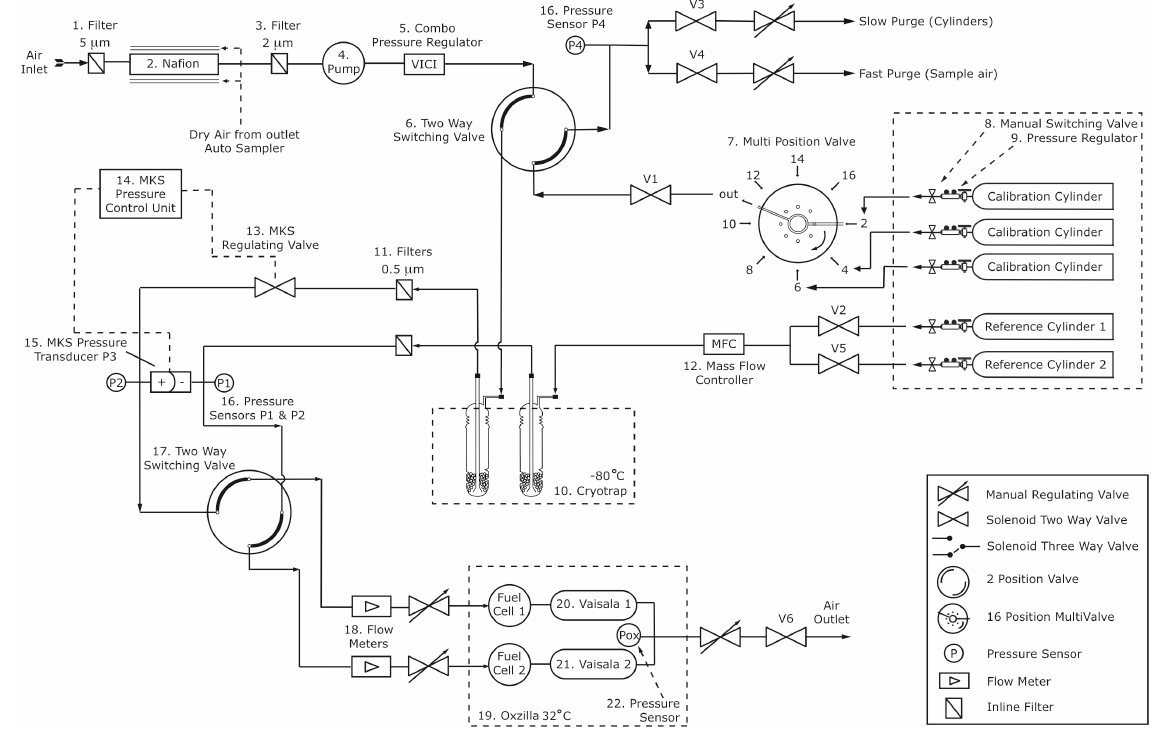
Fig. 1. Schematic of the measurement setup for continuous on-site O 2 and CO 2 measurements. The included gas handling techniques are shown: sample drying (see also Fig. 2) and pressure and temperature